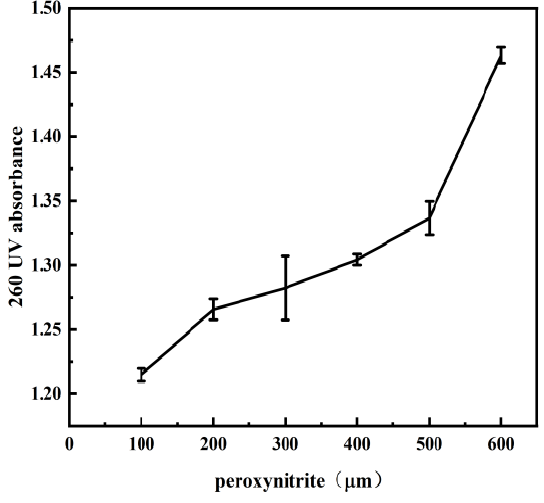
Figure 4. A total of 260 nm absorbance of DNA at different concentrations of